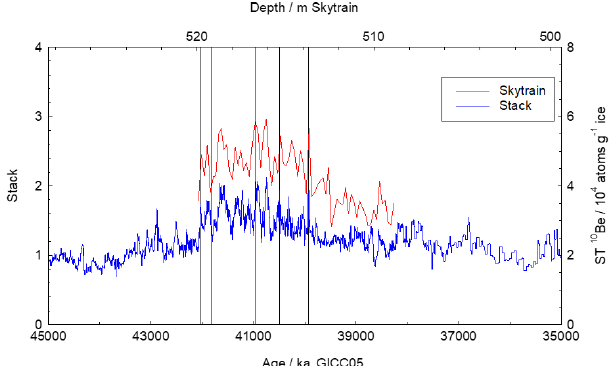
Figure 6. 10 Be concentration in the Skytrain (ST) ice core (red) compared to the normalised stack of ice core radionuclide data (Adolphi et al., 2018). Two samples with obvious low outlier con- centrations in the ST record have not been plotted. Vertical lines show the tie points used in this study.